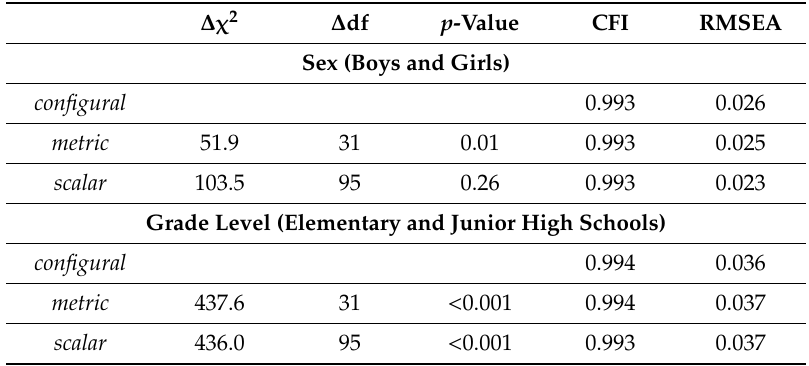
Table 3. Fit statistics for a single-factor solution confirmatory factor analysis testing measurement invariance across sex and grade level.